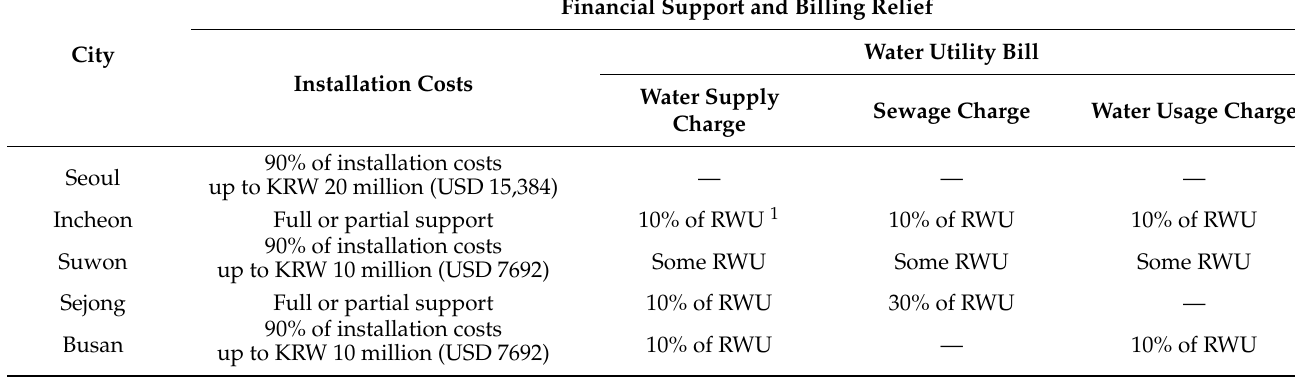
Table 1. The costs and benefits of the installation and operation of rainwater harvesting systems (USD 1 = KRW